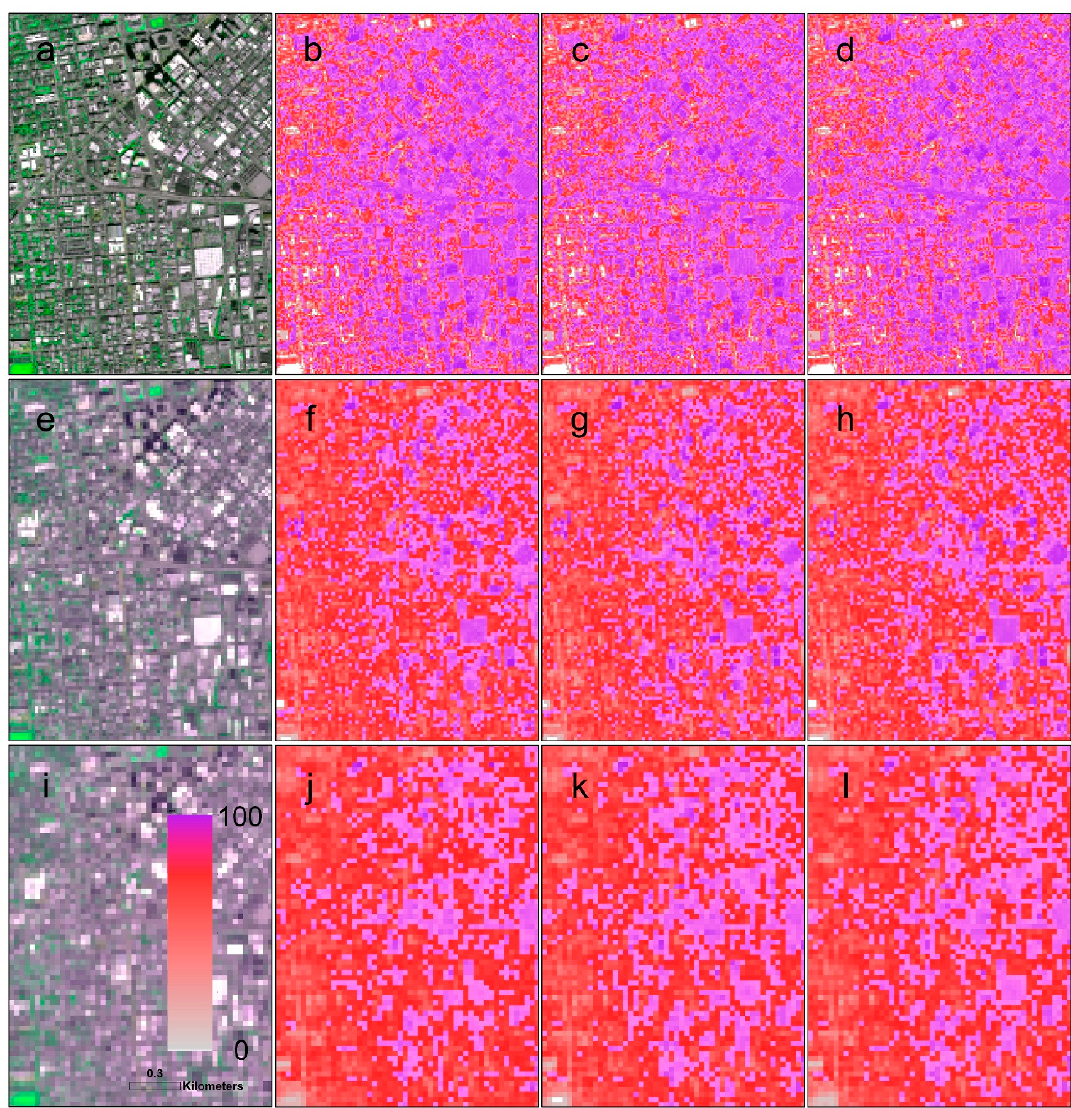
Figure 8. WV3 images at 10-m ( a ), 20-m ( e ), and 30-m ( i ) resolutions from the highlighted area in Figure 7a and derived ISAs from images with half, three-quarters, and twice the Landsat OLI SNRs at 10-m ( b – d ), 20-m ( f – h ), 30-m ( j – l ) resolutions. The non-ISAs are in white.